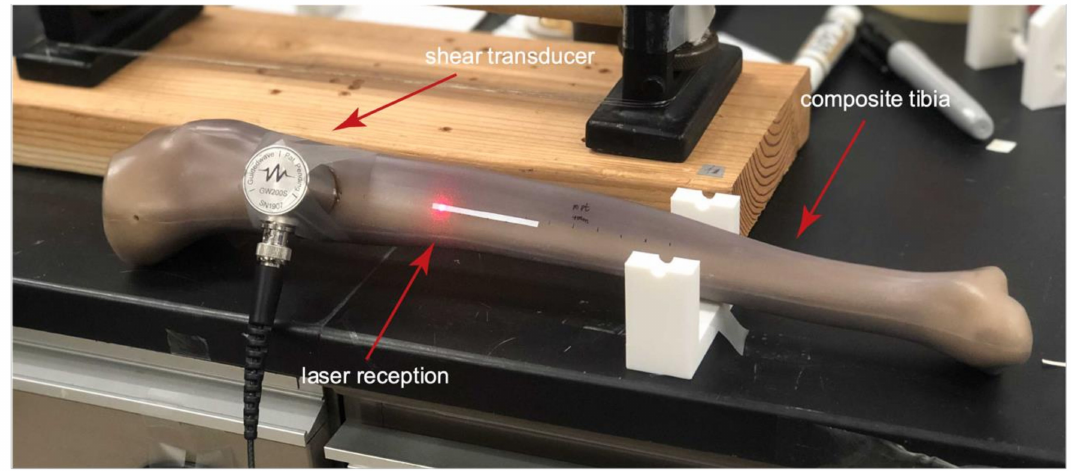
Figure 2. The experimental setup comprises a synthetic tibia, an omni-directional shear transducer, and reflective tape for laser Doppler vibrometer (LDV)